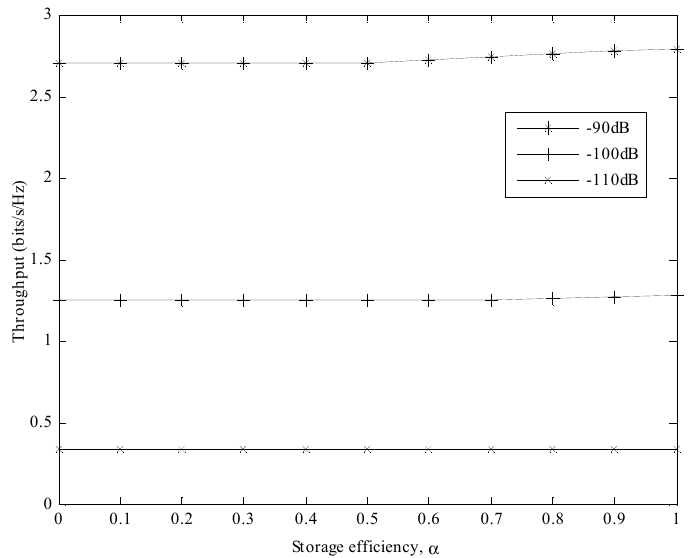
Figure 6. Throughput of the proposed offline algorithm for the time-invariant channel with energy arrivals obeying the uniform distribution of [5, 15] mJ.